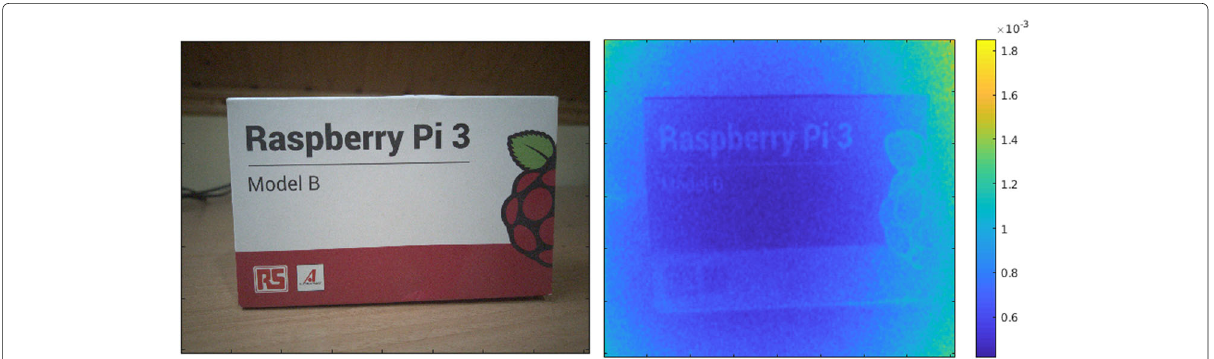
Fig. 2 An example of the PRNU leakage problem, where both text and the shape of the elements in the image are preserved in the estimated PRNU. (Left) Sample image containing textual and graphical information; (Right) PRNU extracted from 24 dark images and the image in the left, all coming from the same